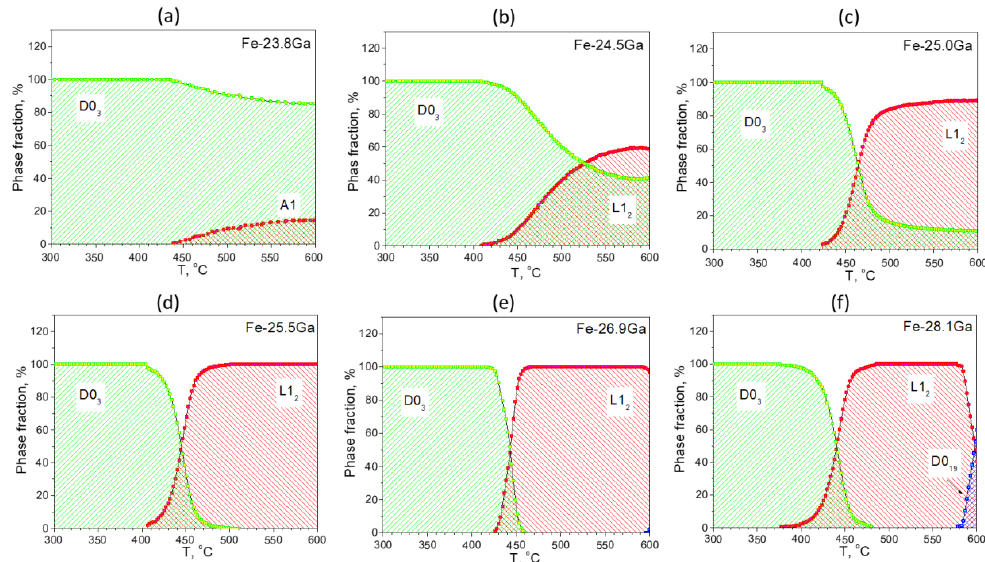
Figure 19. Phase fraction dependencies on the temperature at heating for the Fe–23.8Ga ( a ), Fe–24.5Ga ( b ), Fe–25.0Ga ( c ), Fe–25.5Ga ( d ), Fe–26.9Ga ( e ), and Fe–28.1Ga ( f ) alloys. Dependencies are obtained from the in situ neutron diffraction measurements performed at heating rate 2 ◦ C/min [60]. The D0 3 to L1 2 phase transition takes place in all studied alloys. In the alloys from 23.8 to 25.0%Ga, volume fraction of the L1 2 phase increases, but it is not equal to